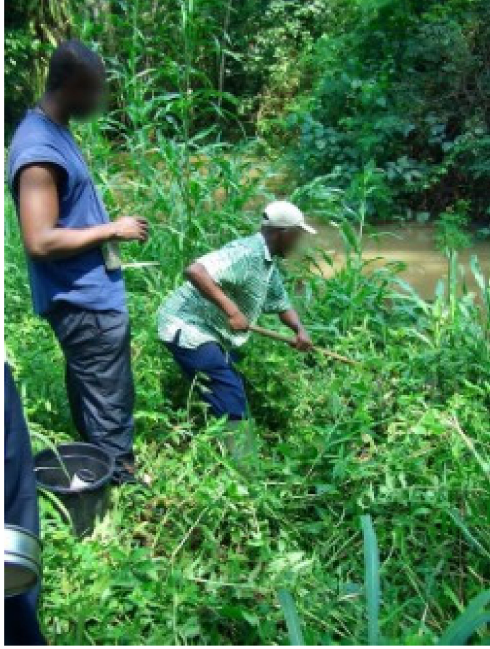
Figure 9. The rich biodiversity of stream, river and lake marginal wetlands throughout Africa, such as this example from Ghana, are under constant threat from unsustainable water extraction and landuse pressures to meet increasing economic needs and poverty alleviation. Source: Edward